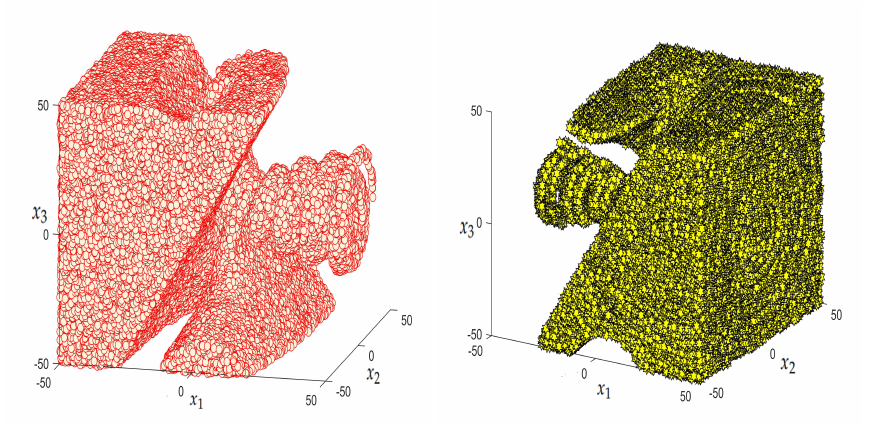
Figure 5. Three-dimensional basin of attraction based on 10 million discrete points using